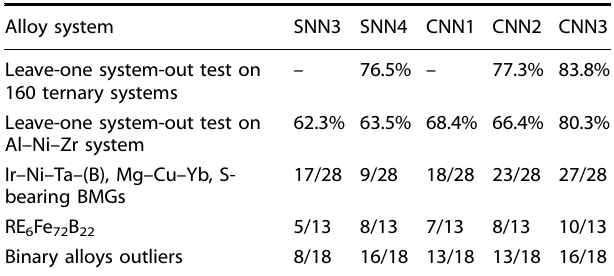
Table 2. Comparison of models ’ prediction accuracy on unseen alloy